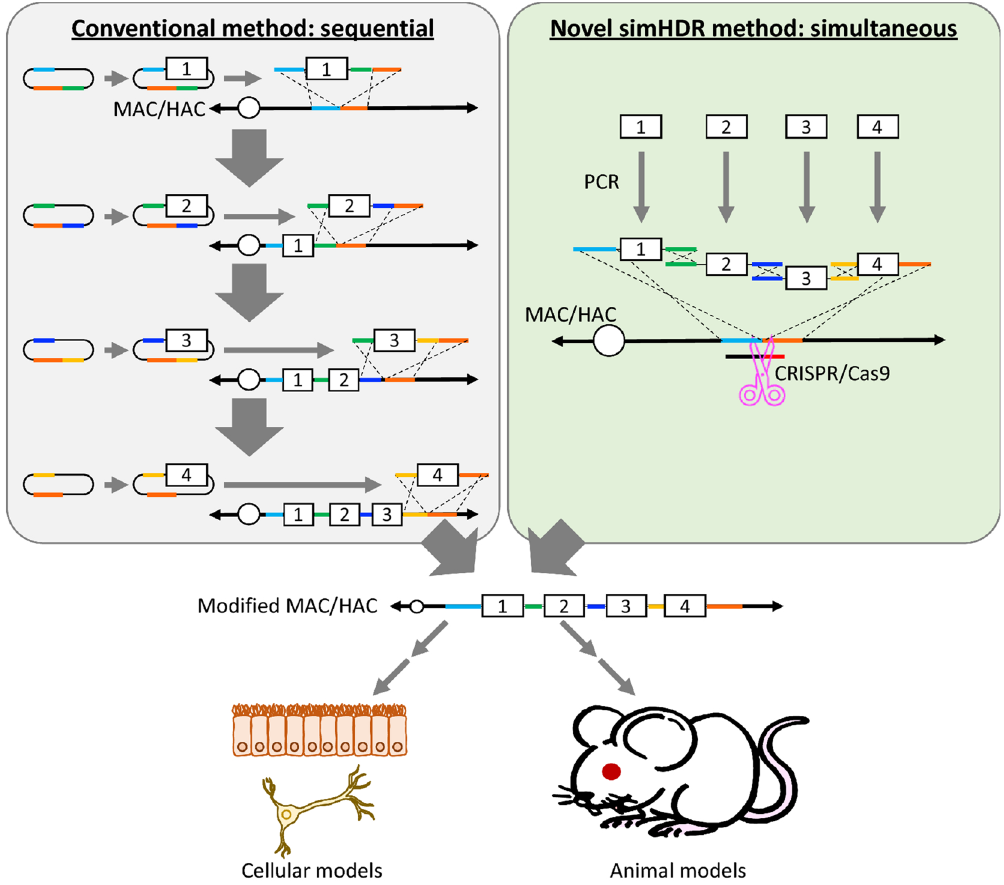
Figure 1. Schematic depiction of generating genetically modified models using MAC/HAC loaded with multiple HDR donors via conventional and novel methods. Conventional loading method of multiple HDR donors sequentially is shown in left. Novel loading method of multiple HDR donors simultaneously as reported in this study is shown in right. Constructed MAC/HAC contained multiple HDR donors that can subsequently be used for generating genetically modified cellular and animal